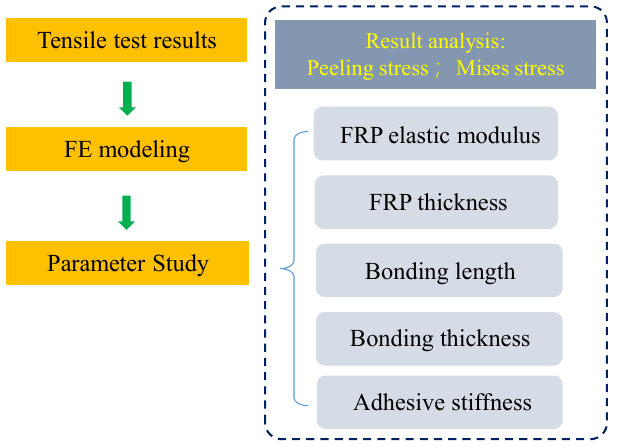
Figure 8. Workflow of the parametric studies.